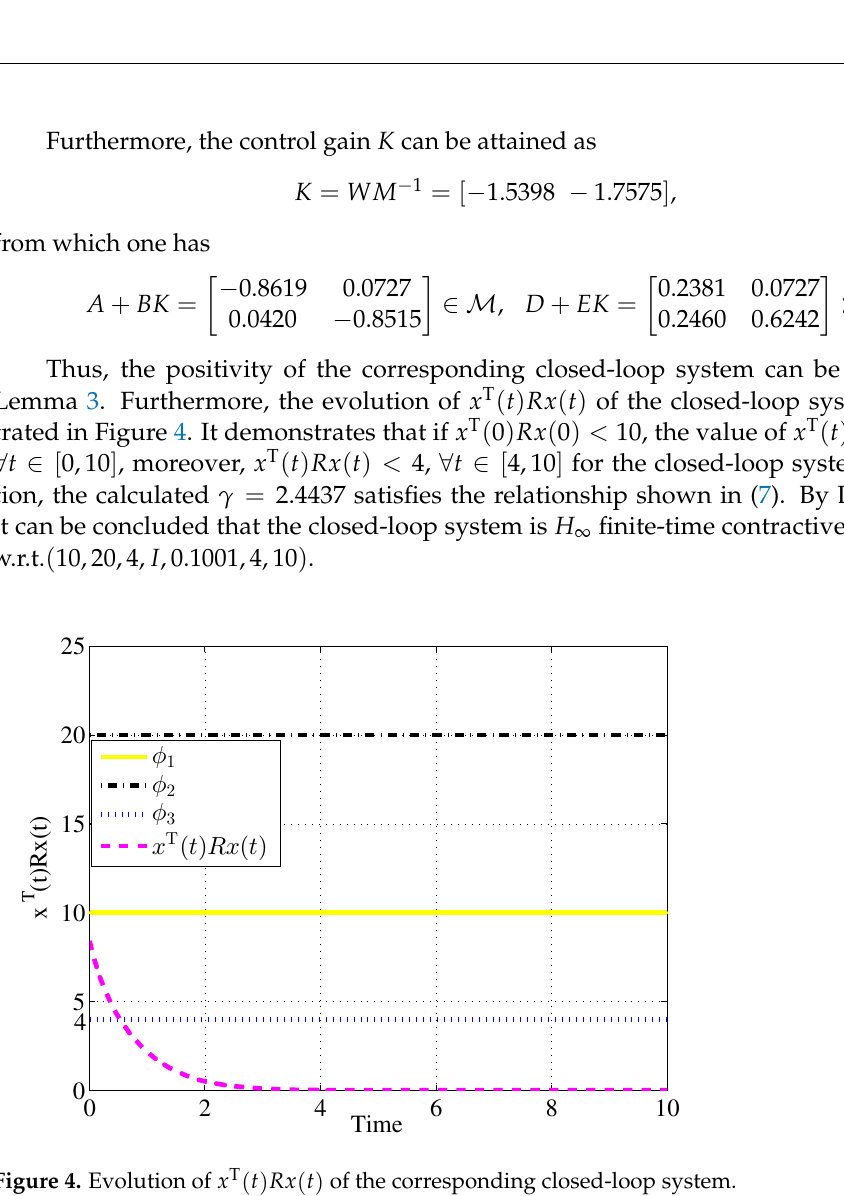
Figure 4. Evolution of x T ( t ) Rx ( t ) of the corresponding closed-loop